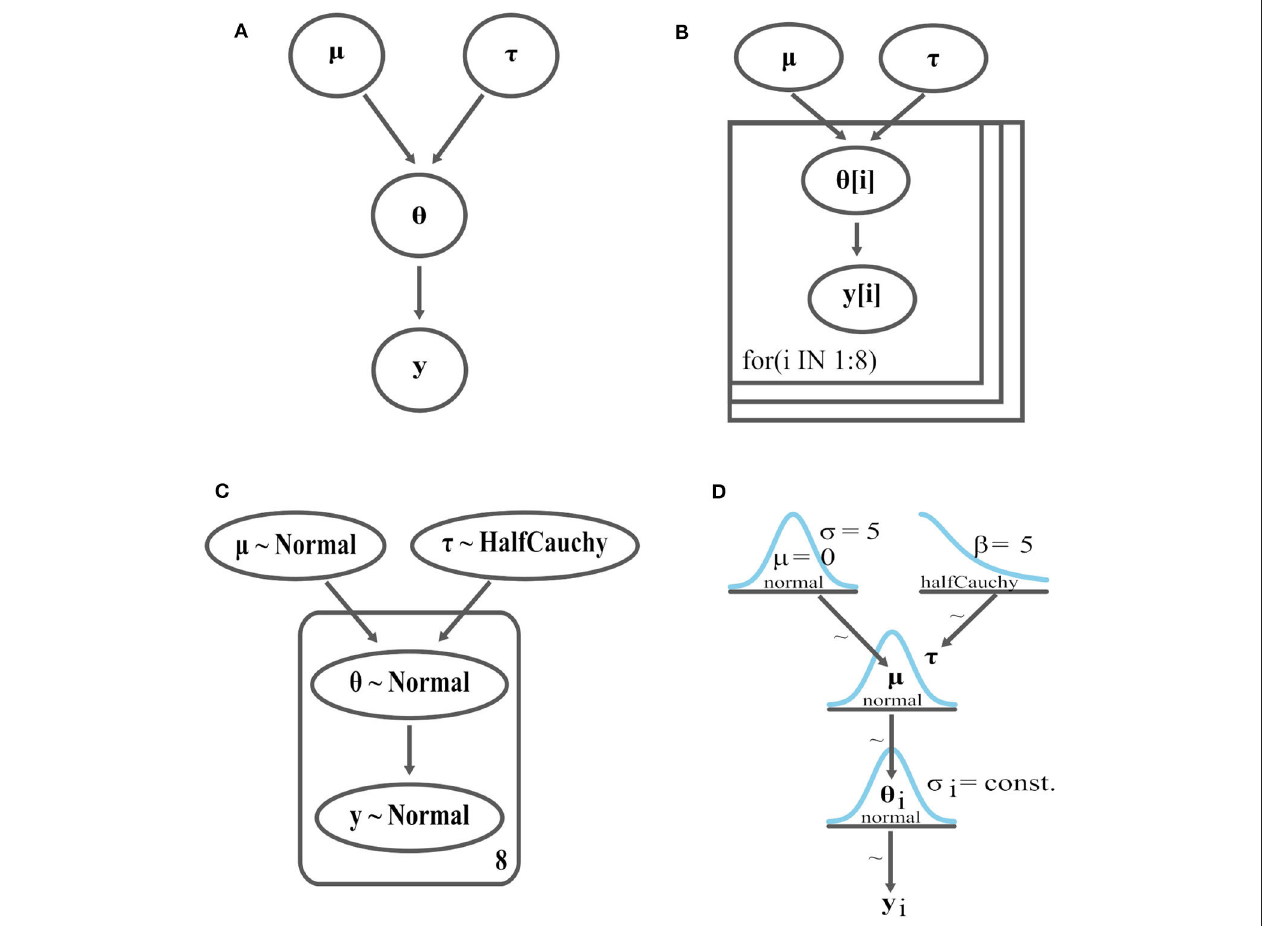
FIGURE 3 | Graphical representations of the eight schools model, (A) Bayesian network, (B) DoodleBUGs graph, (C) PyMC3 graph using the Graphviz interface, (D) Kruschke-style diagram. These representations do not include estimations of the parameters’ posterior uncertainty based on the simulation of real-data (i.e., MCMC